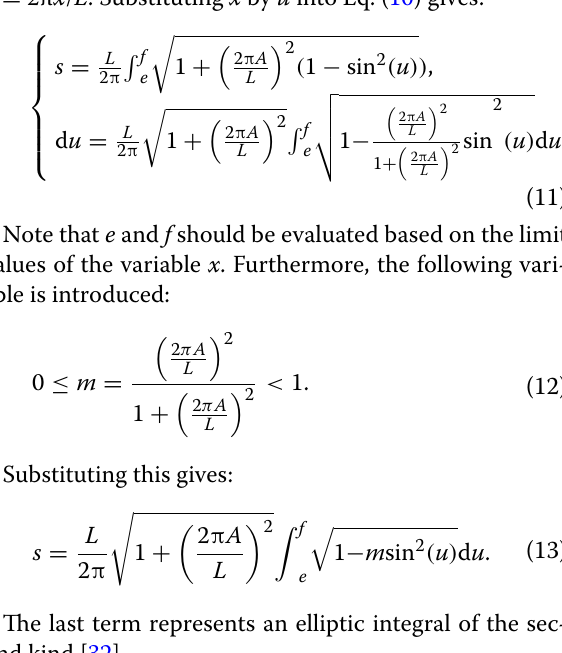
Figure 11 Edge may require support depending on the